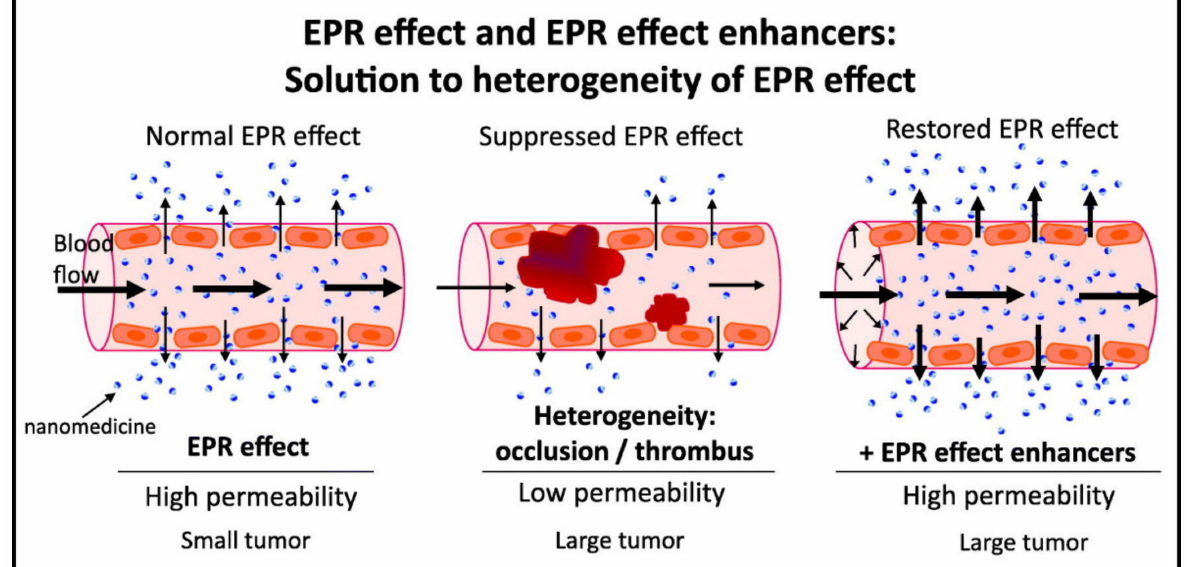
Figure 6. Schematic description of the enhanced and permeability retention (EPR) effect and application of EPR effect enhancers for the solution of heterogenicity of tumor tissue. Reprinted with permission from [101]. Copyright (2020) Elsevier B.V. (Amsterdam,